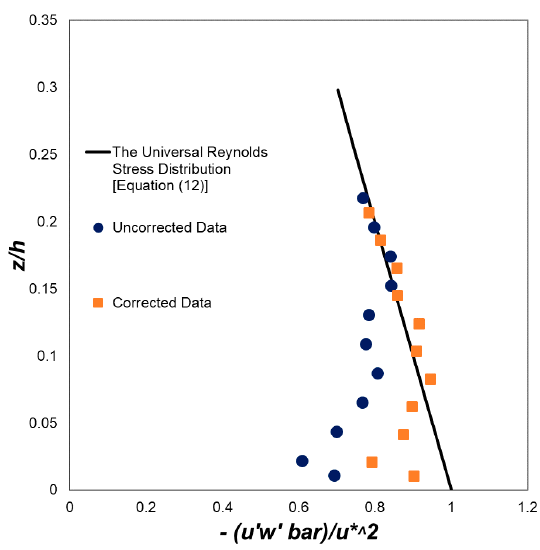
Figure 8. Normalised Reynolds stress over the well-packed laboratory-prepared rough bed.